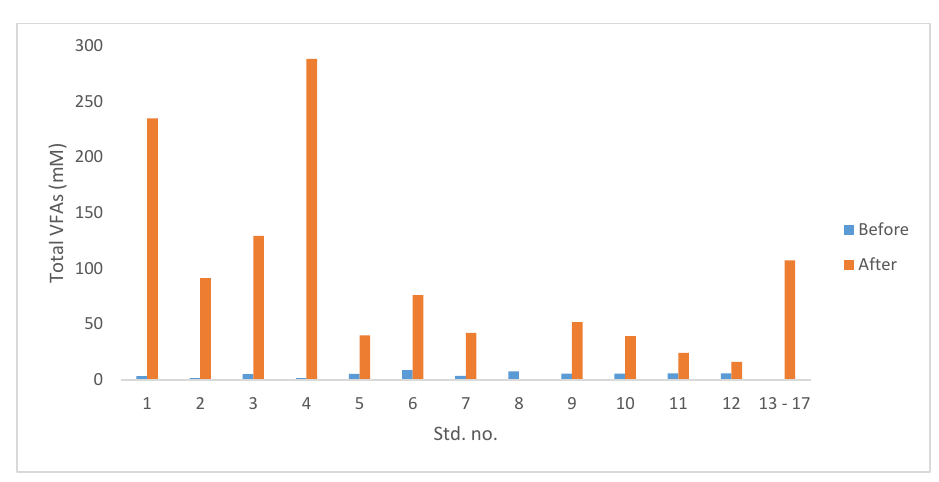
Figure 4. Total VFAs before and after AD of pot ale.